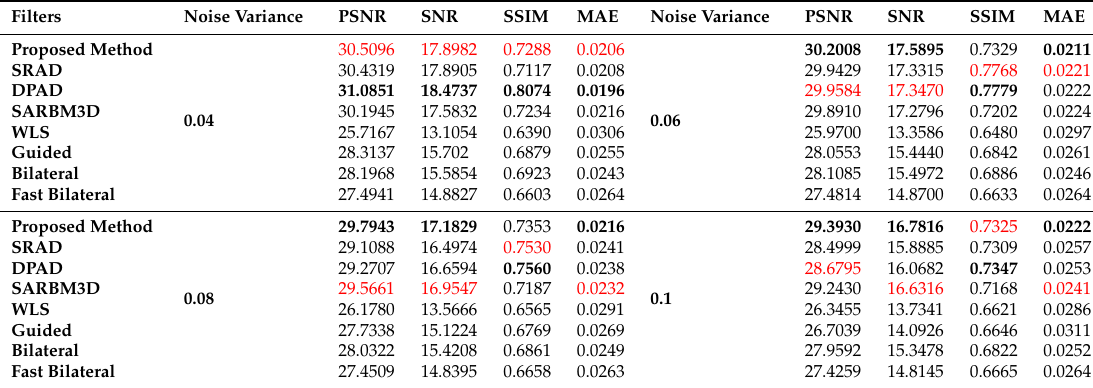
Table 10. PSNR, SNR, SSIM, and MAE results for SAR image 3 (The best value is shown in bold and the second-best value is shown in red